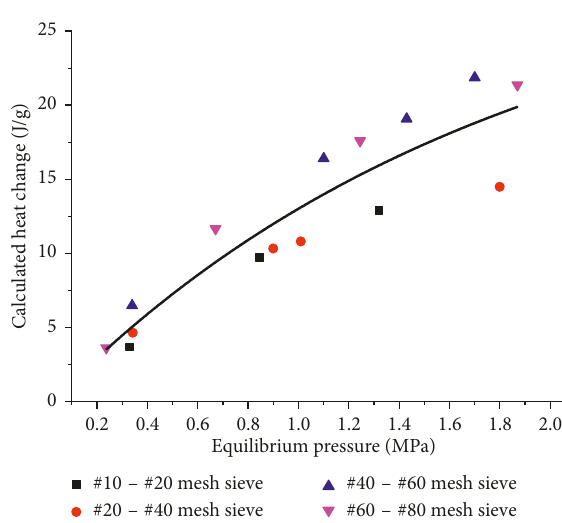
Figure 5: Measured desorption heat values of Zhenxing